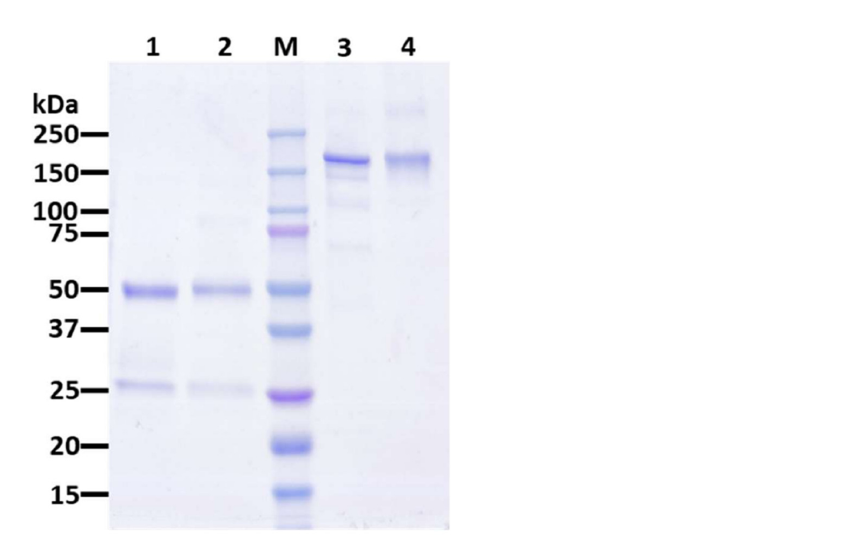
Figure 1. Western blot analysis of plant-produced IL6RmAb (pIL6RmAb). IL6RmAb was purified from N. benthamiana leaves and separated on SDS-PAGE gels under reducing ( A , C ) or non-reducing ( B ) conditions. After transferring the proteins to onto PVDF membranes, a house radish peroxidase (HRP)-conjugated goat anti-human kappa chain antibody ( A , B ) or an HRP-conjugated goat anti-human gamma chain antibody ( C ) were used to detect light chain or heavy chain, respectively. Lane 1, protein sample (~25 µg) from non-infiltrated leaves; Lane 2, protein sample (1 µg) from leaves infiltrated with IL6RmAb-expressing construct; Lane 3, protein sample of purified human IgG (1 µg).